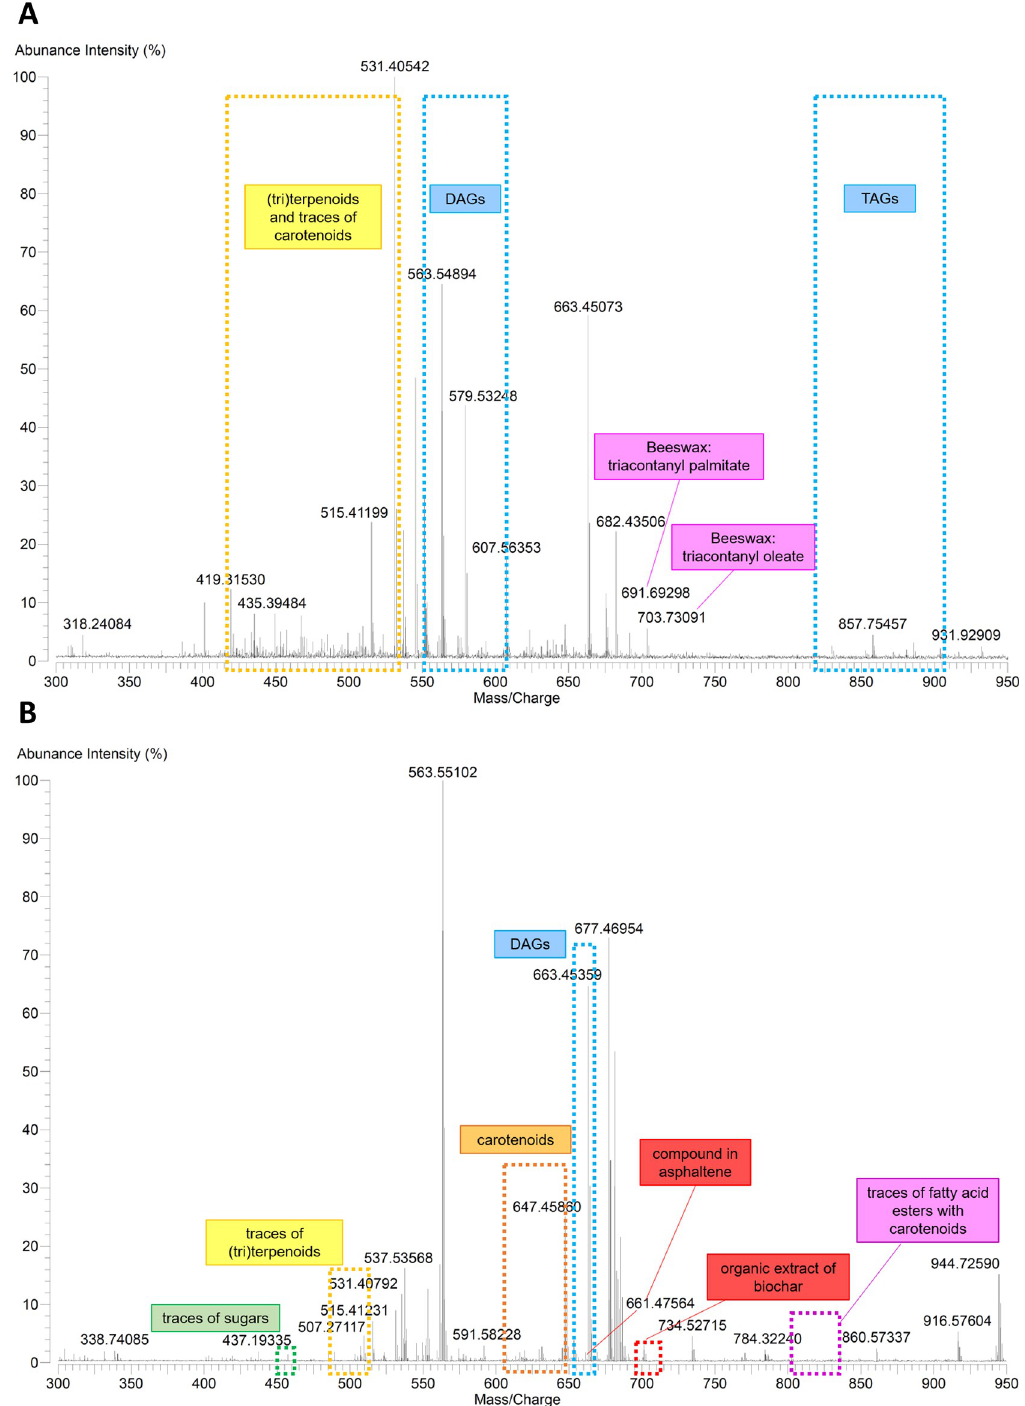
Fig 6. ESI-FT-ICR-MS spectra with identified compounds. A—sample OM S4; B—sample YM S4.